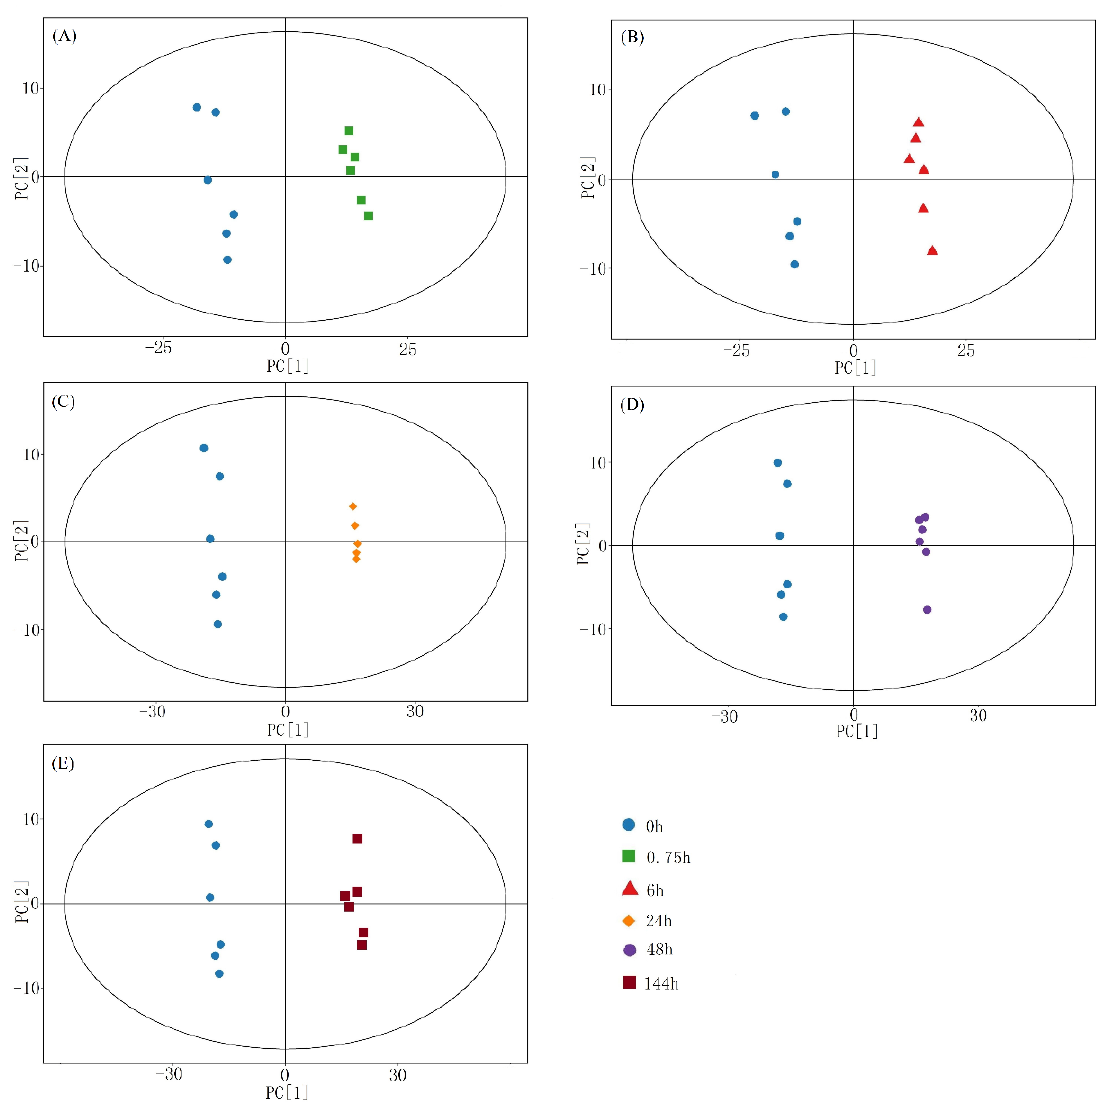
Figure 1. Principal component analysis (PCA) score plots of metabolic profiles during different seed germination times. ( A – E ) PCA score plots of seed germination at 0 and 0.75 h ( A ), 0 and 6 h ( B ), 0 and 24 h ( C ), 0 and 48 h ( D ), and 0 and 144 h ( E ).